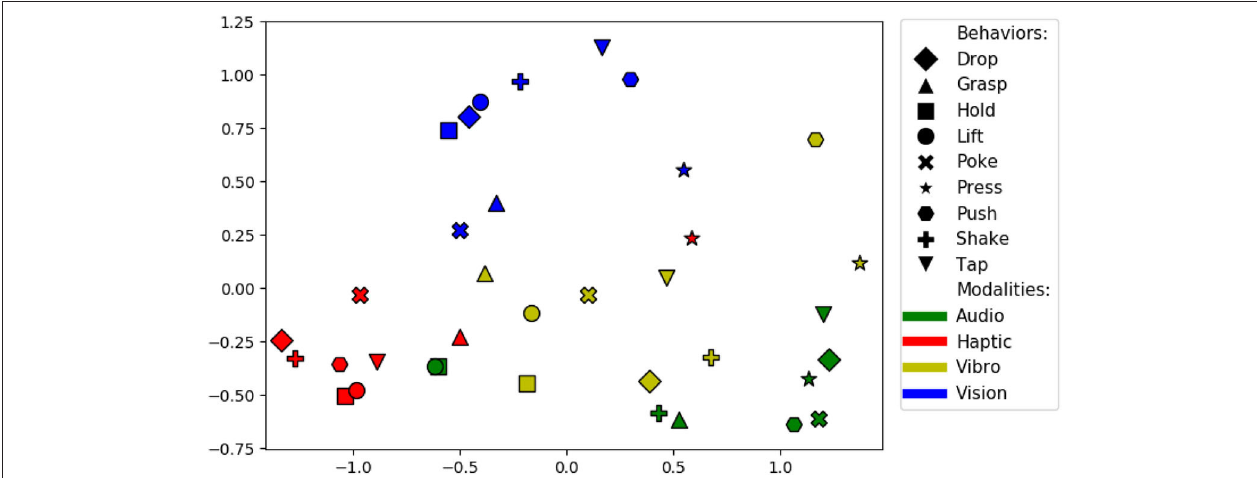
FIGURE 19 | Two dimensional ISOMAP embedding of the accuracy delta matrix. Each point represents a sensorimotor context (i.e., a combination of a behavior and sensory modality). Points close in this space represent contexts between which information can be transferred